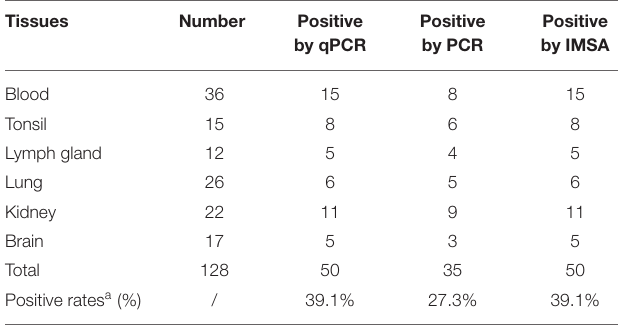
TABLE 2 | Detection of PCV3 in clinical samples by the colorimetric IMSA qPCR and PCR.